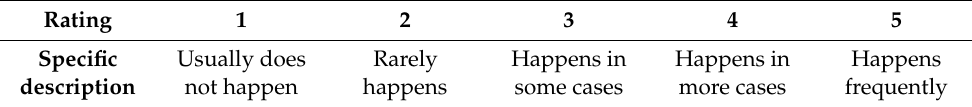
Table 2. Classification levels of failure